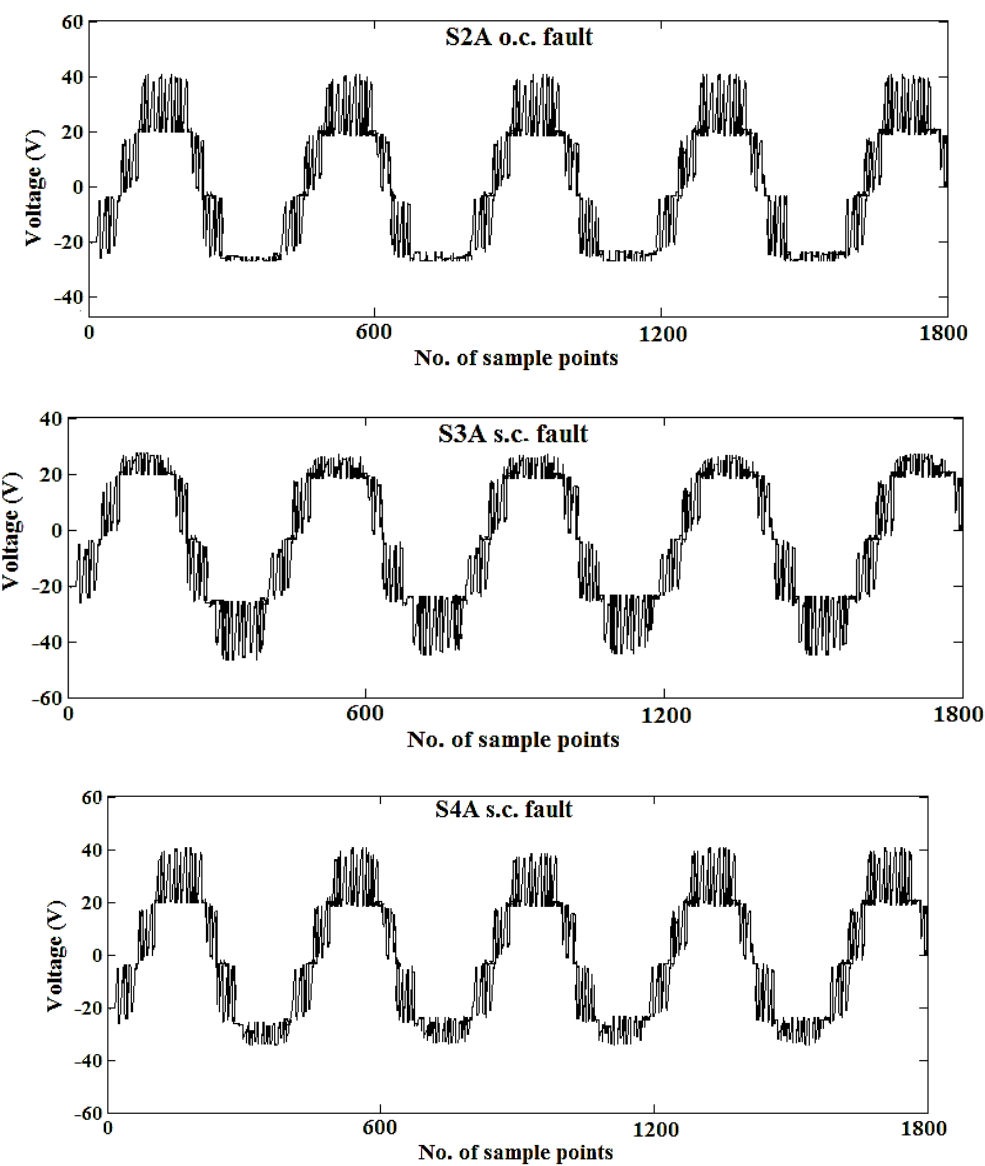
Figure 21. Voltage waveforms acquired at different open circuit and short circuit switch fault situations .